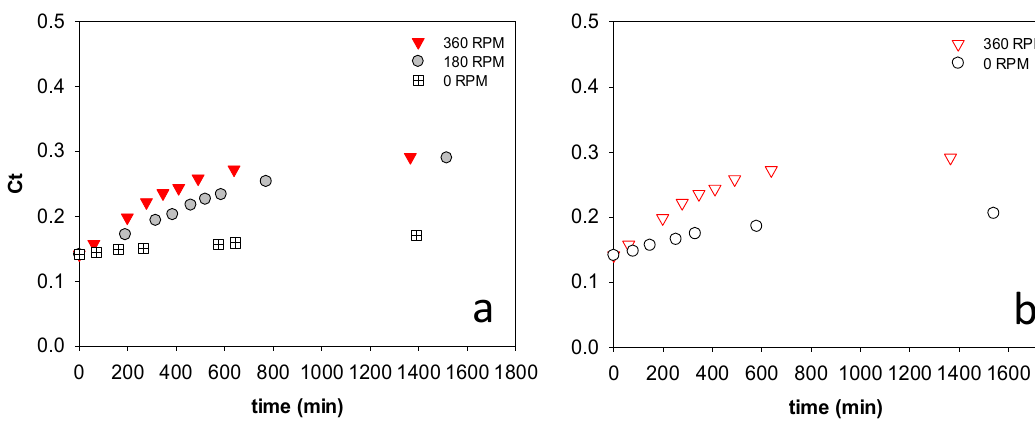
Figure 4. Stick water solids mass fraction change with time using ( a ) different feed side stir speeds and constant draw solution stir speed of 360 rpm and ( b ) different draw solution stir speeds and constant feed stir speed of 360 rpm.